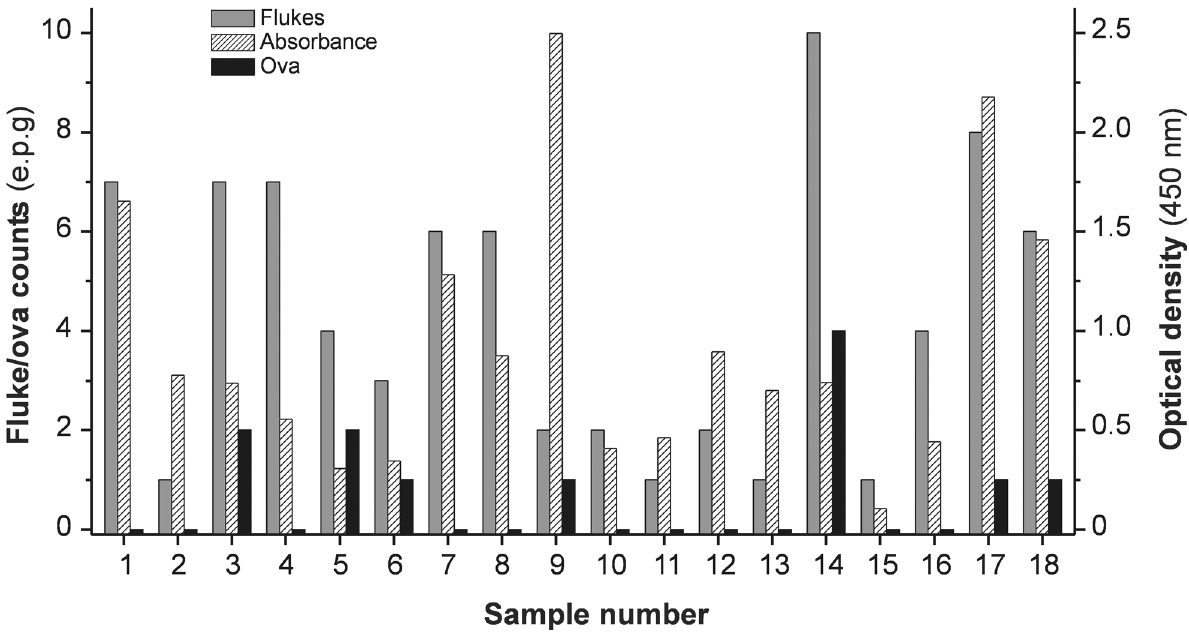
Fig 6. Fecal egg counts, fluke burden and OD values obtained by testing fecal samples from cows naturally infected with Fasciola hepatica (n = 18) with the rapid enhanced MM3-COPRO ELISA. Fluke burdens were determined at necropsy. MM3-COPRO ELISA was performed with short incubations (30 min at RT with shaking) and with SA-PolyHRP as secondary reagent, which was revealed with TMB (model